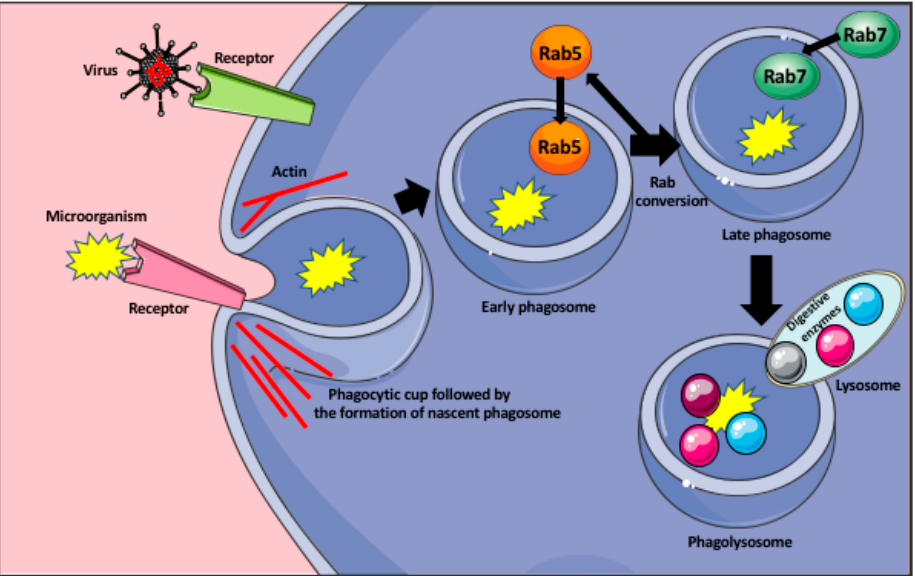
Figure 1. Phagocytosis of microorganisms by macrophage. Recognition of the microorganism (bacteria, or virus) by the appropriate receptor induces the formation of the phagocytic cup that engulfs the microorganism and pinches off the membrane as a nascent phagosome. The formation of the phagocytic cup and detachment of the phagosome from the membrane are actin dependent. The nascent phagosome recruits small GTPase Rab5 that induce its remodeling and becomes the early phagosome. In the process of the Rab conversion, the early phagosome loses Rab5 and acquires Rab7 becoming the late phagosome. The Rab7 induces signaling pathways allowing the late phagosome to fuse with the lysosomes, containing various digestive enzymes, and become the phagolysosome that degrades the microorganism.